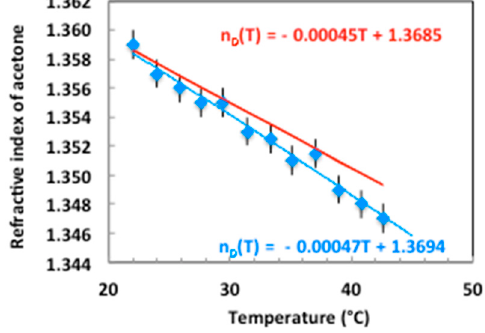
Figure 5. Refractive index of acetone versus temperature—measurements in blue and theoretical curve in red.